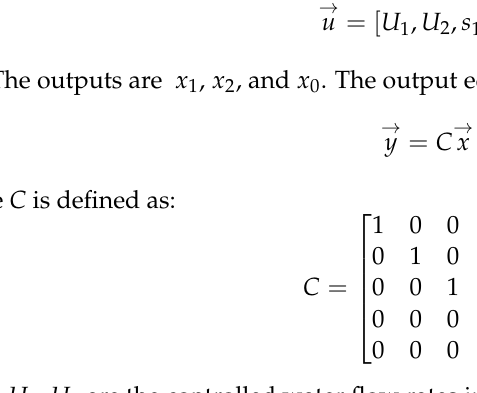
Figure 3. System model in Simulink. 3. Control Design The three-pound system must maintain the water level in ponds at a predefined level. Compared to a single pond, this system is distinguished from the conventional R.O.R. system by its three-pond mechanism. This working model analyses the water dynamics of the system. This work does not include a turbine, whereas the water level regulation of the system is performed by a Fuzzy Inference Engine (F.I.E.).Fuzzy Infer- ence Engine or fuzzy control is used due to its flexibility in maintaining the water levels for the three ponds at different levels. Another advantage of using a fuzzy controller is its higher speed (especially in terms of settling time for this case, as the Fuzzy Controller settles as soon as the desired level is achieved and has no overshoot) and accuracy than traditional P.I.D. controllers. The advantage of the fuzzy controller over PID in terms of